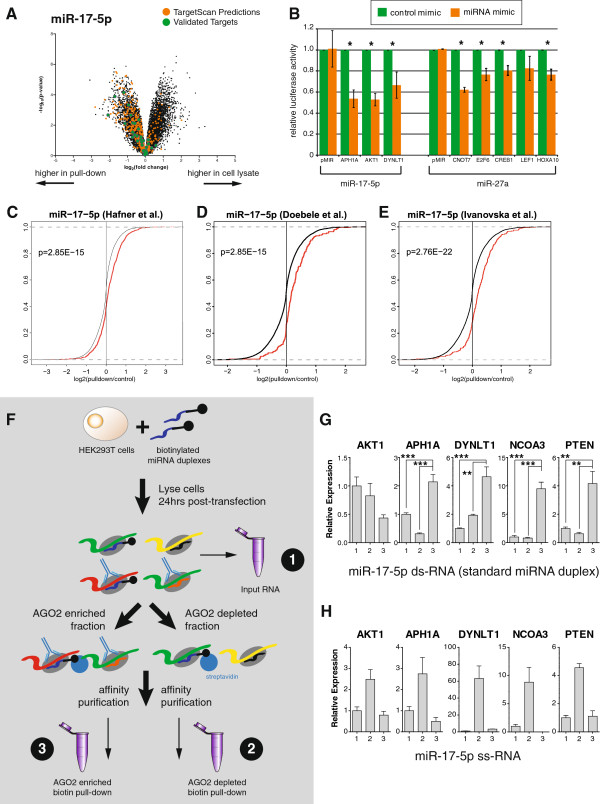
Biotin pull-downs identify bone fide miRNA targets. (A) Volcano plot showing the significance of the difference in expression between the miR-17-5p pull-down and the mock-transfected control, for all transcripts expressed in HEK293T cells. Both targets predicted by TargetScan or validated previously via luciferase assay were significantly enriched in the pull-down compared to the controls. (B) Results from luciferase assays on previously untested targets predicted using TargetScan and uncovered using the biotin pull-down. The plot indicates mean luciferase activity from either the empty plasmid or from pMIR containing a miRNA binding site in the 3′ UTR, relative to a negative control. Asterisks indicate a significant reduction in luciferase activity (one-sided t-test; P < 0.05) and error bars the standard error of the mean over three replicates. (C-E) Targets identified through PAR-CLIP or through miRNA over-expression studies show greater enrichment in the pull-down. Cumulative distribution of log fold-change in the pull-down for transcripts identified as targets by the indicated miRNA over-expression study or not. Red, canonical transcripts found to be miR-17-5p targets in the indicated study (Table S5 in Additional file 1); black, all other canonical transcripts; p, one-sided P-value from Kolmogorov-Smirnov test for a difference in distributions. (F) To confirm that our results were dependent on RISC association, cells were transfected with either single or double-stranded synthetic miRNAs, then subjected to AGO2 immunoprecipitation. The biotin pull-down was performed in the AGO2-enriched and AGO2-depleted fractions. (G-H) Quantitative RT-PCR revealed that, with double-stranded (ds) miRNA (G), four out of five known targets were enriched relative to input mRNA (*P ≤ 0.05, **P < 0.01, ***P < 0.001) in the AGO2-enriched but not in the AGO2-depleted fractions, but this enrichment was not seen for the cells transfected with a single-stranded (ss) miRNA (H). The numbers on the x-axis correspond to those in Figure 2F. Error bars represent the standard error of mean (sem).